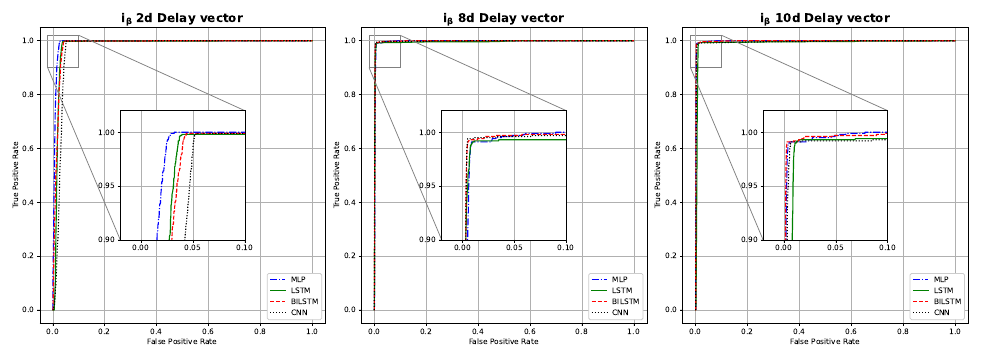
Figure 13. Comparison for I β with different d values.